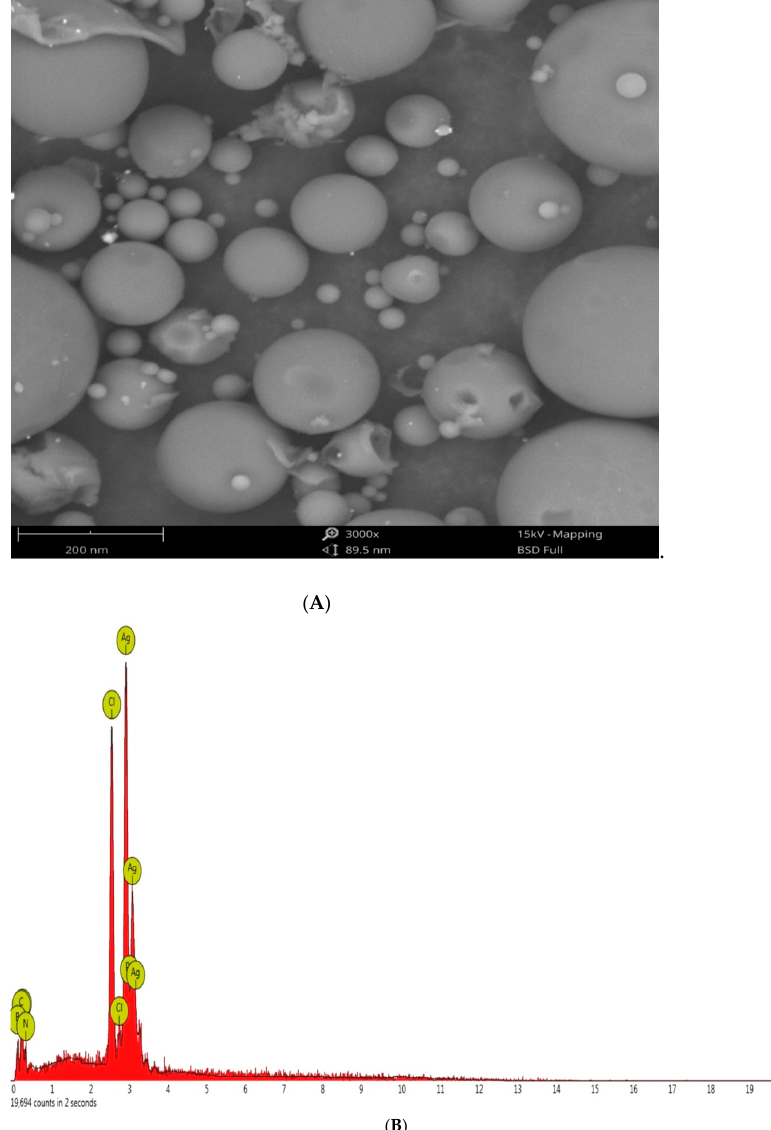
Figure 6. SEM image ( A ) and EDX image ( B ) of Eh-AgNPs.